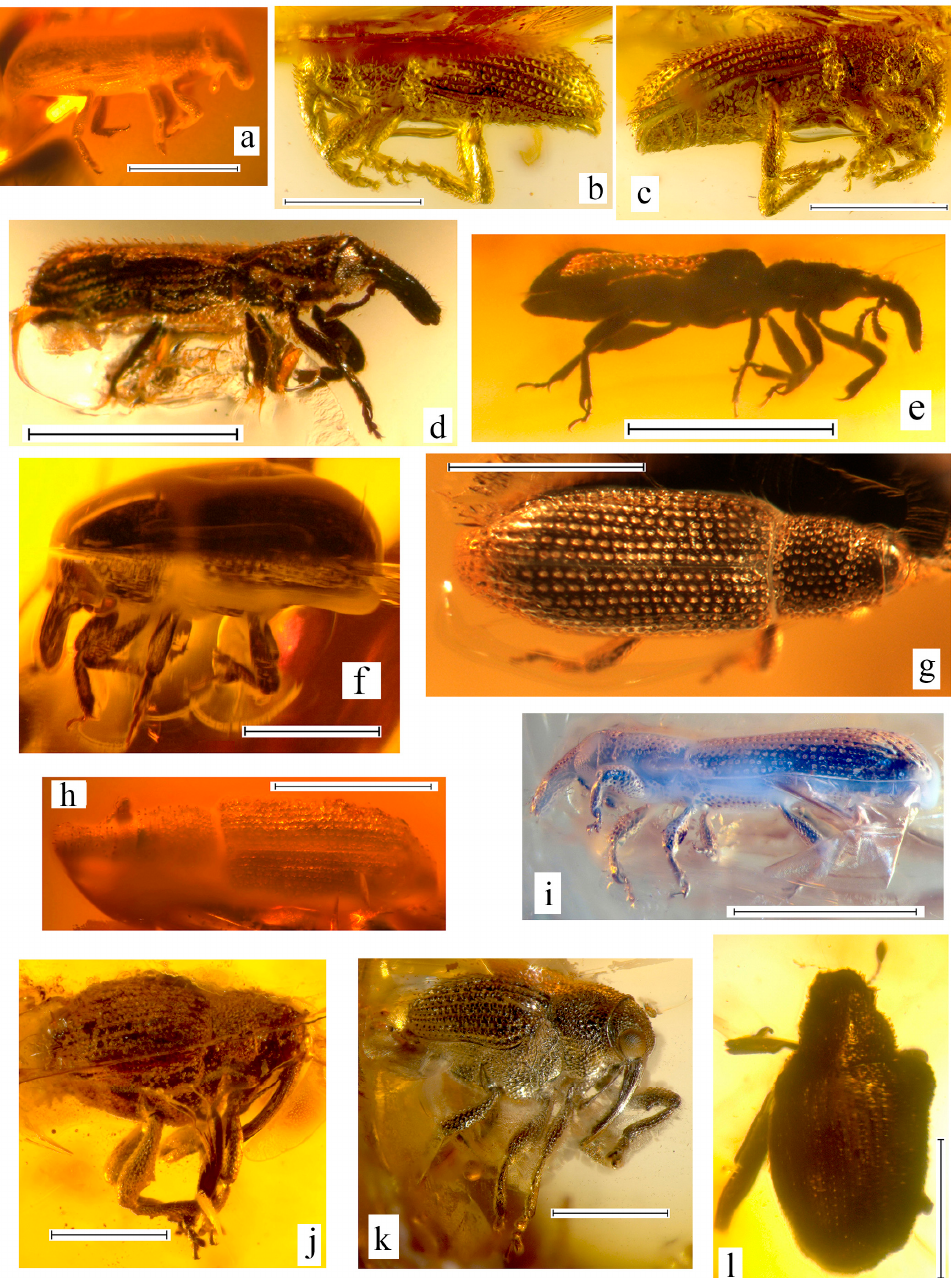
Figure 7. Habitus of Curculionidae from Baltic amber. ( a , h ) Ampharthropelma decipiens , holotype, ZMUC , no. 958: body, laterally ( a ); body, dorsally ( h ). ( b , c ) Electrocossonus kirejtshuki , holotype, ISEA , no. BA2017 / 5: body, laterally, on the left ( b ); body, laterally, on the right ( c ). ( d ) Caulophilus squamosus , holotype, ISEA , no. BA2012 / 9, body, laterally. ( e ) C. rarus , holotype, ISEA , no. BA2011 / 5, body, laterally. ( f ) Synommatodes patruelis , holotype, GPIH, no. 202, body, laterally. ( g ) Caulophilus sucinopunctatus , holotype, EIW , no. 554, body, dorsally. ( i ) Caulophilus sucinopunctatus , specimen, ISEA , no. BA2011 / 3, body, laterally. ( j ) Ceutorhynchus succinus , holotype, ISEA , no. BA2012 / 3, body, laterally. ( k ) C. electrinus , holotype, ISEA , no. BA2012 / 10, body, laterally. ( l ) C. alekseevi , holotype, CVIA , no AWI-005, body, dorsally. Scale bars: 1.0 mm. See Section 2 for names of collections.